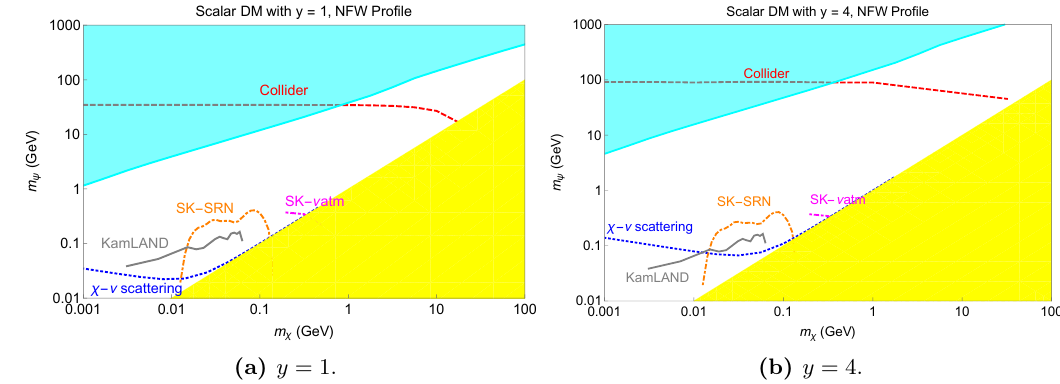
Figure 12. The 90% CL bounds from various neutrino telescope observations compared with the collider bounds in the m (cid:31) - m plane. The gray line, labelled KamLAND, is the (rescaled) o(cid:14)cial KamLAND bound [69]. The green line, labelled SK, is the o(cid:14)cial SK bound [68]. The brown line, labelled IceCube, is the o(cid:14)cial IceCube bound [67]. The orange, dot-dashed line, labelled SK-SRN, is the bound obtained from recasting the SK SRN searches discussed in section 4.1. The magenta, dot-dashed line, labelled SK- (cid:23) atm, is the bound obtained from recasting the SK atmospheric neu- trino measurements discussed in section 4.2. The blue dotted lines are the cosmological bounds from the DM-neutrino scattering discussed in section 2.2. The dashed lines are the bounds obtained by taking the strongest bounds between the LHC mono-lepton and the invisible Z decay width. All the regions below the lines are excluded by the respective observations/experiments. The shaded cyan region is the region that gives (cid:10) (cid:31) h 2 > 0 : 1186 as simulated by Micromegas 5.0 [80]. The shaded yellow region is the region which m (cid:31) > m . In these plots, the dark matter pro(cid:12)le is taken to be the NFW